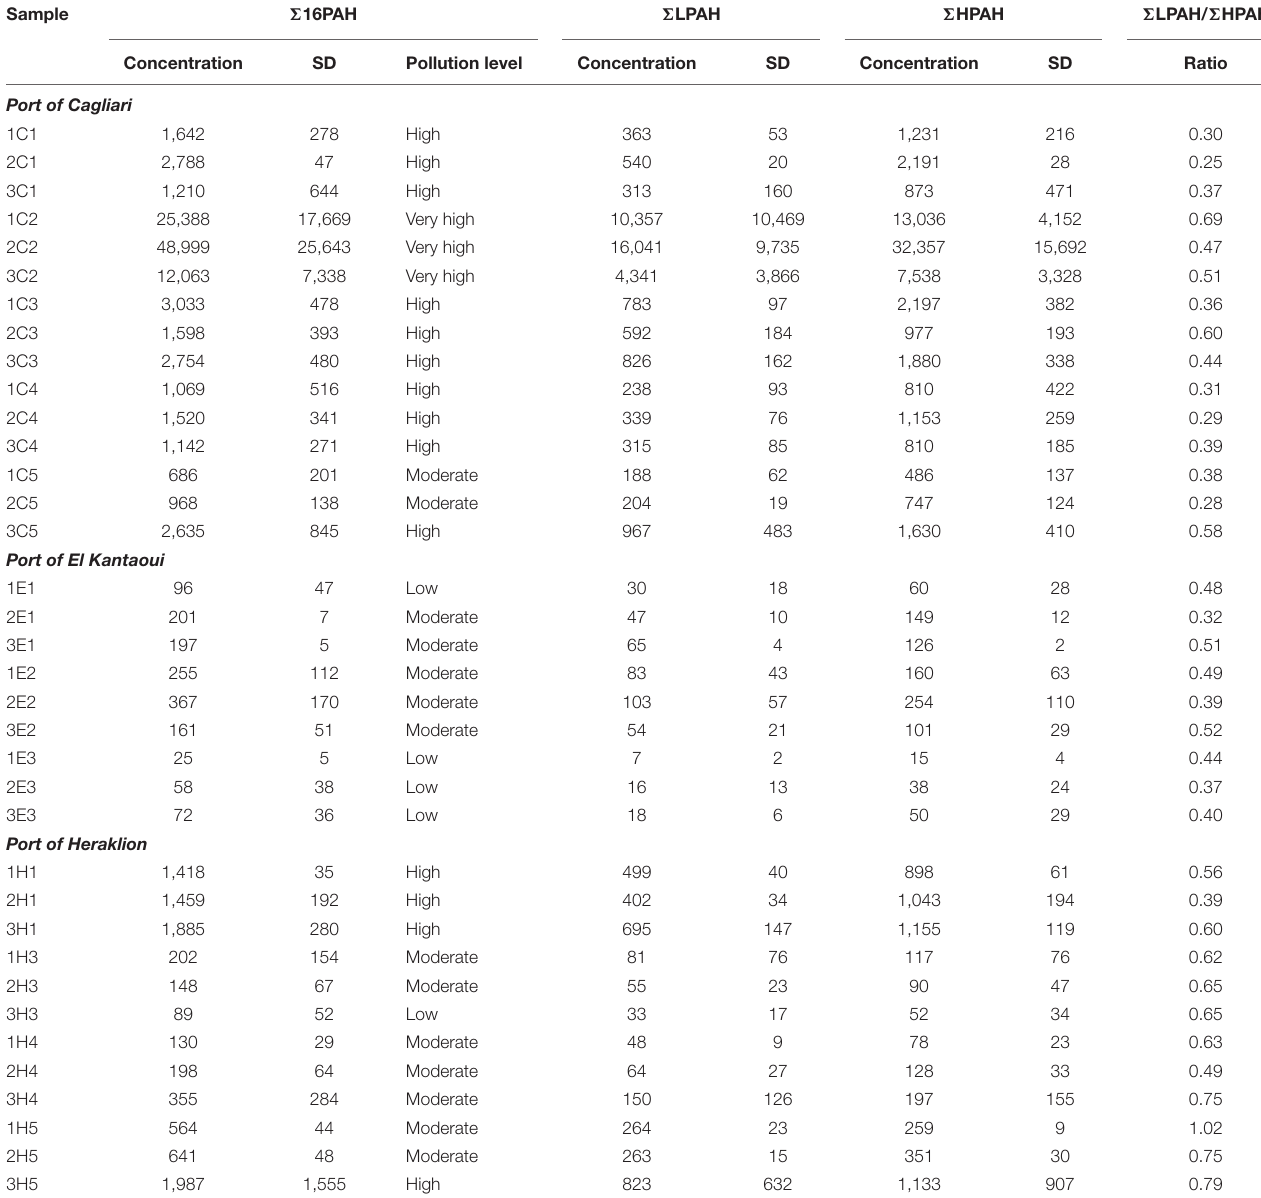
TABLE 2 | Sums of PAH concentrations (ng g − 1 dw), pollution levels according to Baumard et al. (1998), and (cid:54) LPAH/ (cid:54) HPAH ratio in surface sediments from the ports of Cagliari, El Kantaoui, and Heraklion.